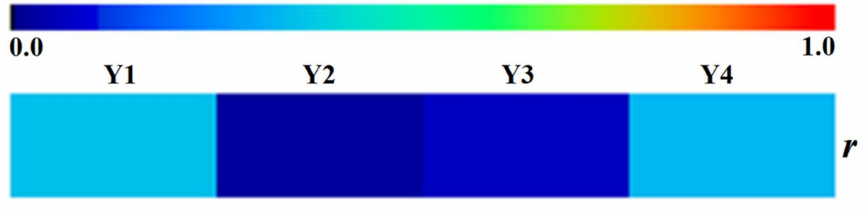
Figure 4. The heat map of the correlation coefficients between the diameter of RP and content of oligosaccharide esters, xanthones, saponins and total focused compounds,